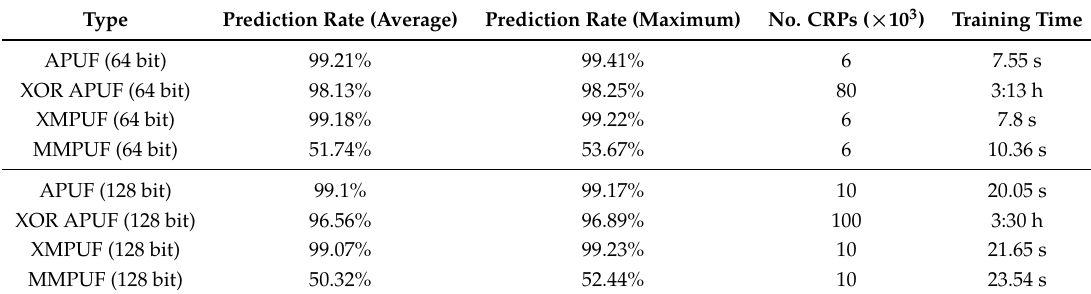
Table 2. Prediction Rates and Training Time for SVM